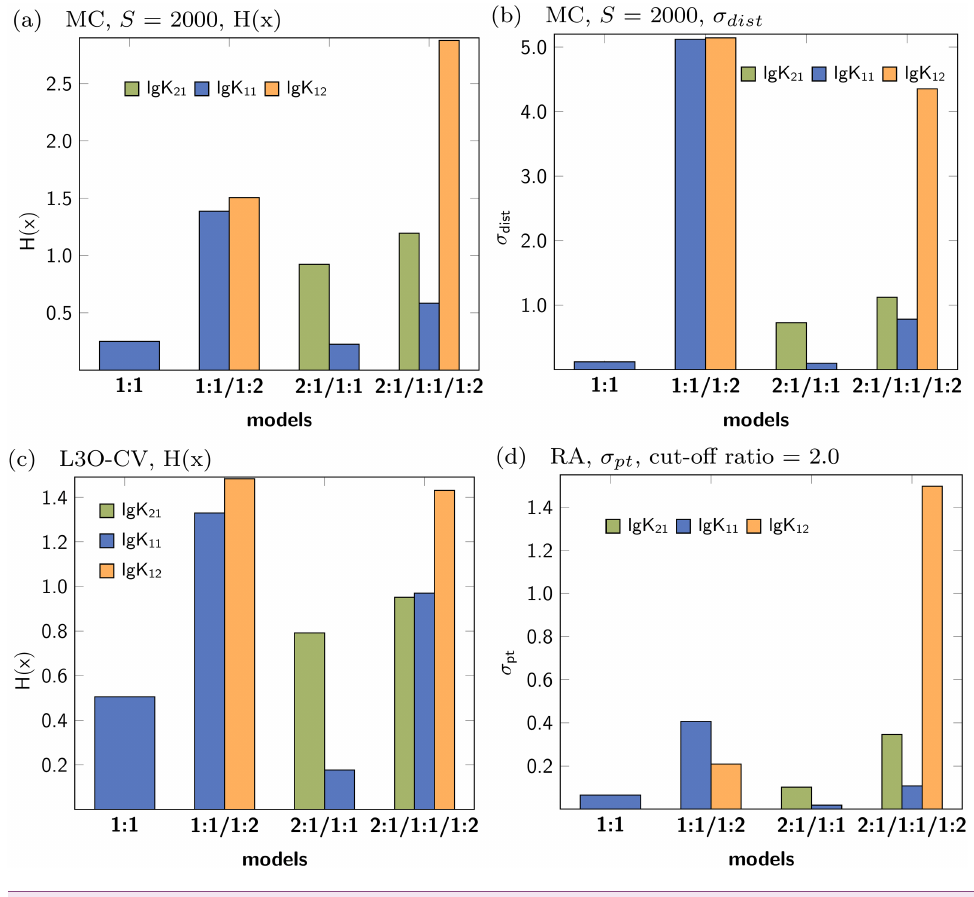
Figure 10 Calculated statistical descriptors for four models (A–D) obtained after Monte Carlo simu- lation, Leave-3-Out Cross Validation and Reduction Analysis performed on a simulated NMR titration with a 2:1/1:1 model. Full-size DOI: